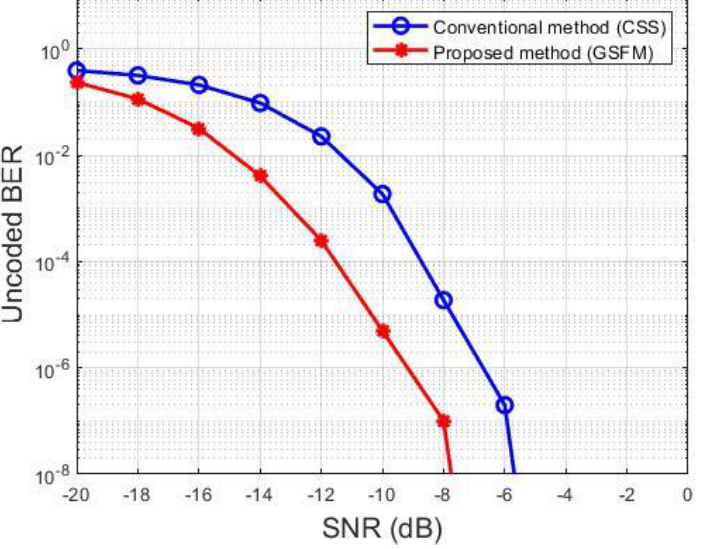
Figure 6. BER performance.